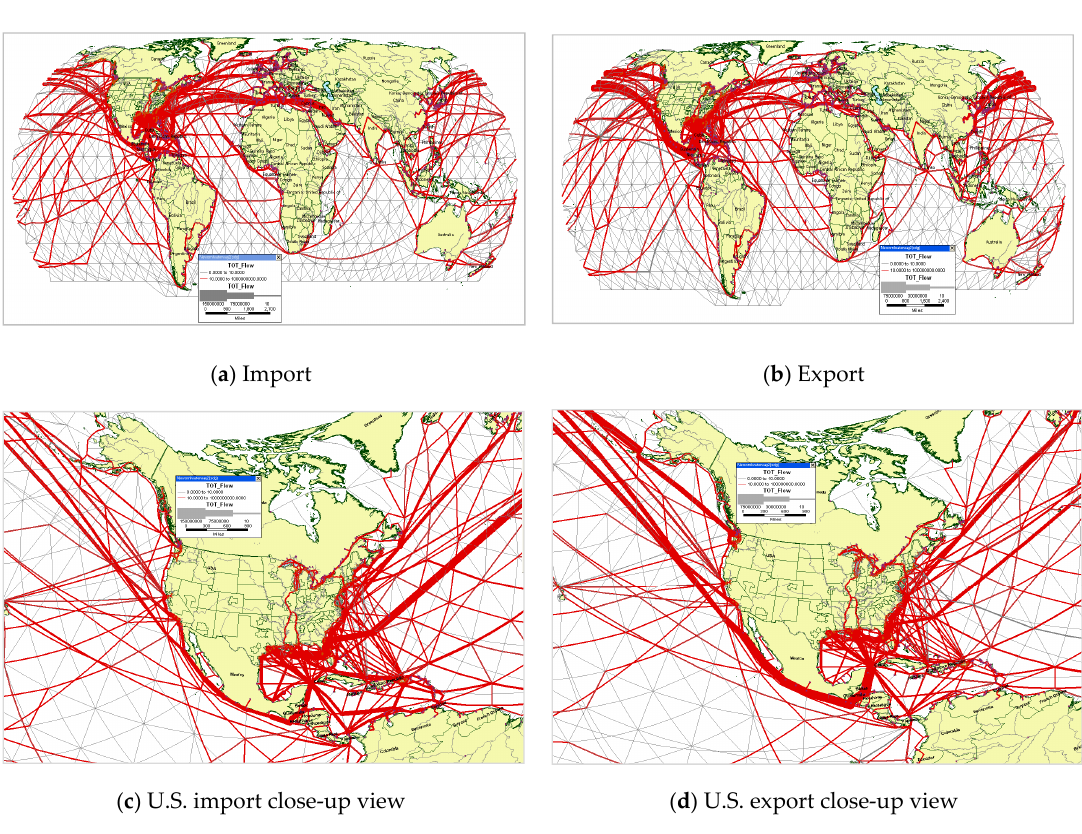
Figure 7. U.S. global total import/export freight ( a , b ) and close-up views ( c , d ) in 2018.